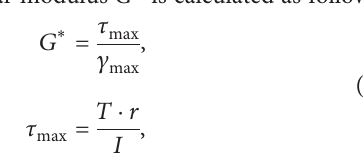
Table 4: Bitumen from EB 60/40 properties after aging and curing.